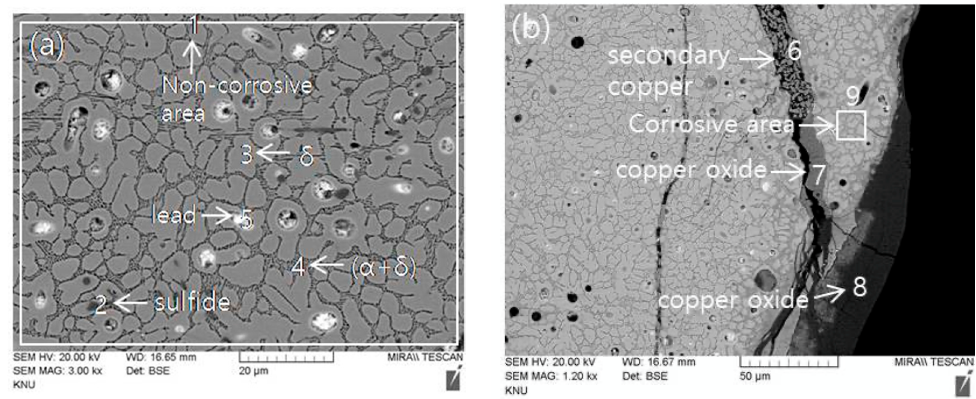
Figure 7. ( a ) Ga-31 (No. 2) scanning electron microscope-energy dispersive spectrometer (SEM-EDS) images that show the original microstructure without corrosion and ( b ) secondary copper present in cracks formed from corrosion compounds.